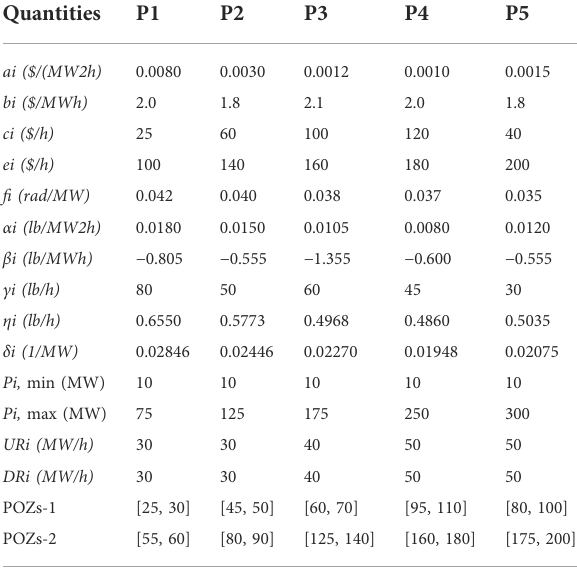
TABLE 2 Data of the 5 unit